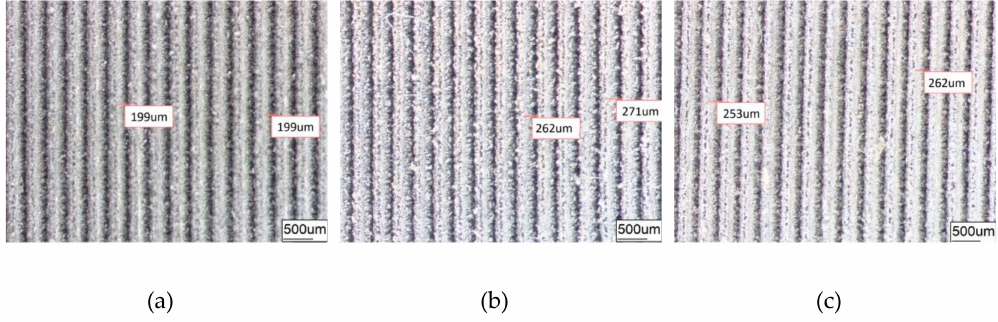
Figure 5. Groove surface texture morphology obtained under di ff erent conditions. ( a ) GST samples; ( b ) GST / CE (Ni) samples; ( c ) GST / CE (Ni-1.5Gr)